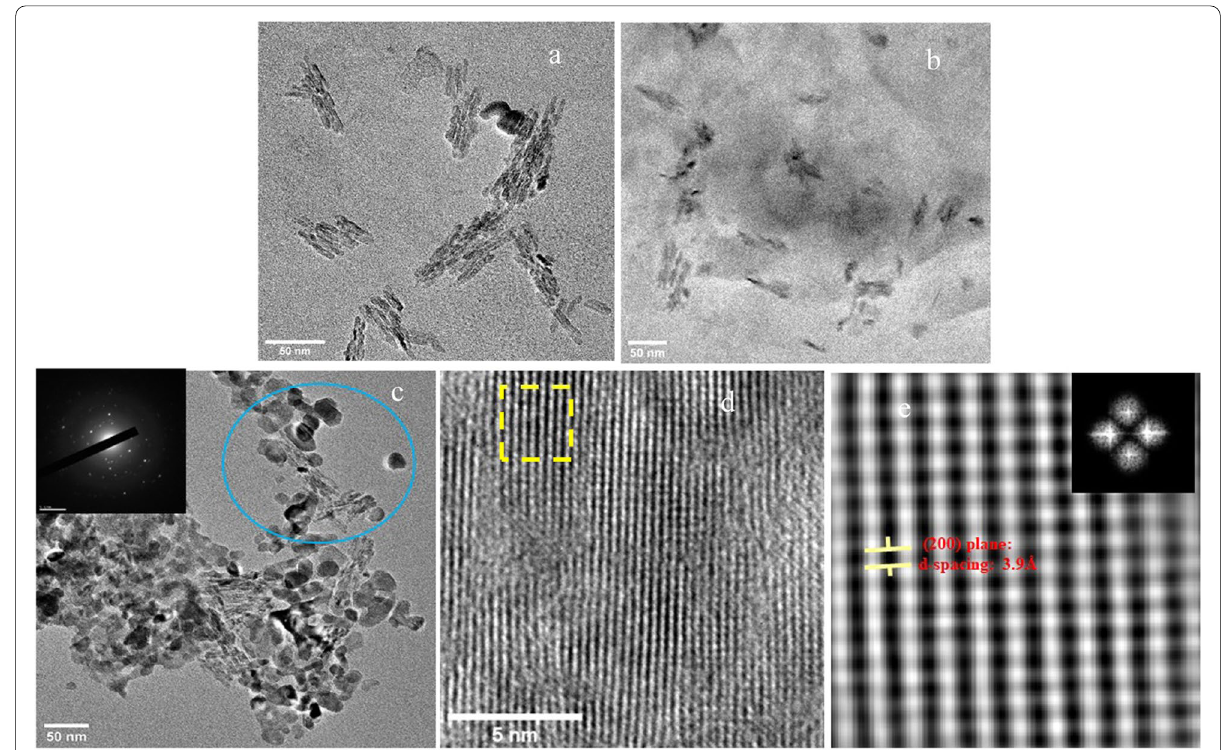
Fig. 3 HR-TEM images of CNC30 ( a ), CNC40 ( b ) and CNC50 ( c , d ) and crystalline lattices ( e ) of spherical CNC